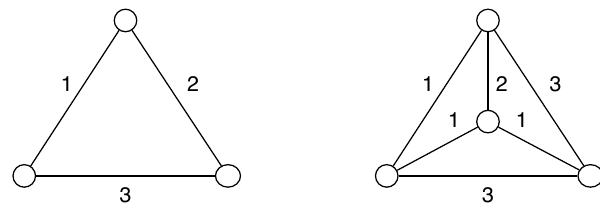
-antimagic labelings ( k (cid:21) 4) of W k